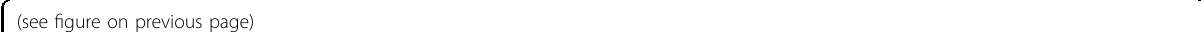
Fig. 7 The ceRNA regulatory property of PlncRNA-1 against the expression of smad3 by miR-136 binding. A qPCR test for the transfection ef fi ciency of anti-miR-136 in T24 and 5637 cells. B qPCR assay for the transfection ef fi ciency of miR-136 mimic in T24 and 5637 cells. C qPCR assay for the expression level of PlncRNA-1 and smad3 in BC cells after miR-136 silencing. D qPCR assay for the expression level of PlncRNA-1 and smad3 in BC cells overexpressing miR-136. E , F Western blot for the expression level of PlncRNA-1 and smad3 in BC cells after miR-136 silencing. G , H Western blot assay for the expression level of PlncRNA-1 and smad3 in BC cells overexpressing miR-136. I Luciferase reporter assay for the association between PlncRNA-1 and miR-136. J , K Rescue experiment shows the relative expression level of smad3 protein in different groups. L , M Rescue experiment shows the relative expression level of EMT marker protein levels in different groups. N Schematic diagram of the PlncRNA-1/miR-136/smad3 axis contributing to the progression of BC. “ ↑ ” indicates upregulation, “ ↓ ” indicates downregulation, “ → ” indicates promotion, and “ CpG ” indicates CpG island. TSS transcription start